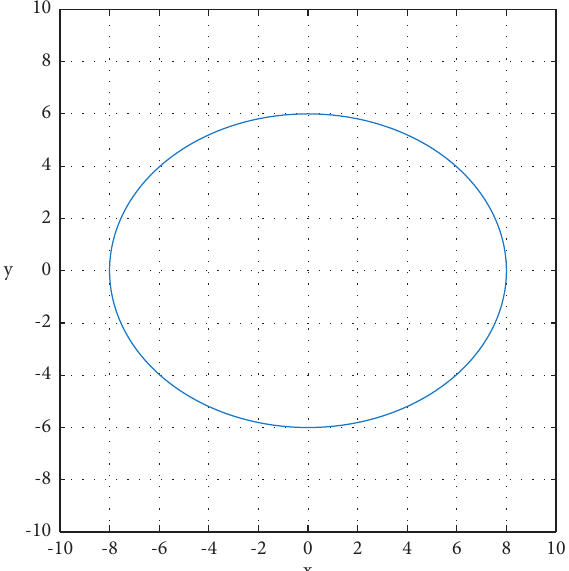
Figure 11: Planer CT-B´ezier spiral curve and its control